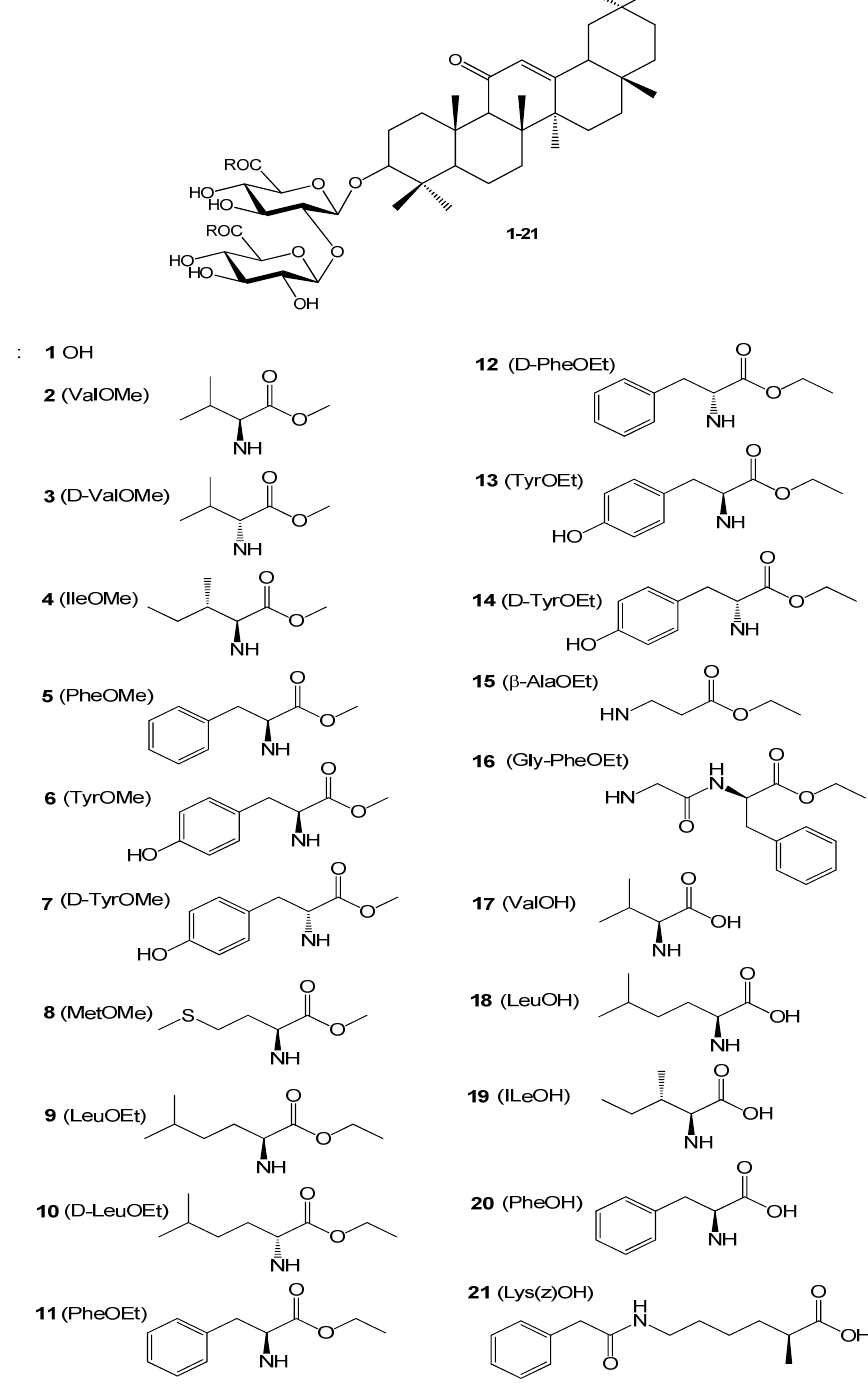
Figure 1. Structure of Glycyrrhizic acid and its conjugates 2 – 21.